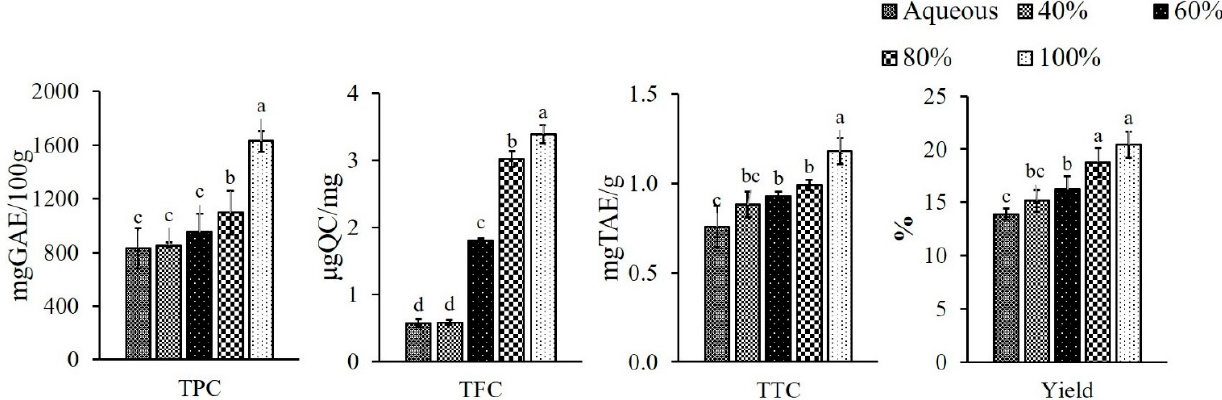
Figure 1. Phytochemicals in pineapple peel extracts (PPE) powder; where TPC—total phenolic content; TFC—total flavonoid content; TTC—total tannin content. Different letters (a, b, c, etc.) on the bars indicate significant differences ( p < 0.05).